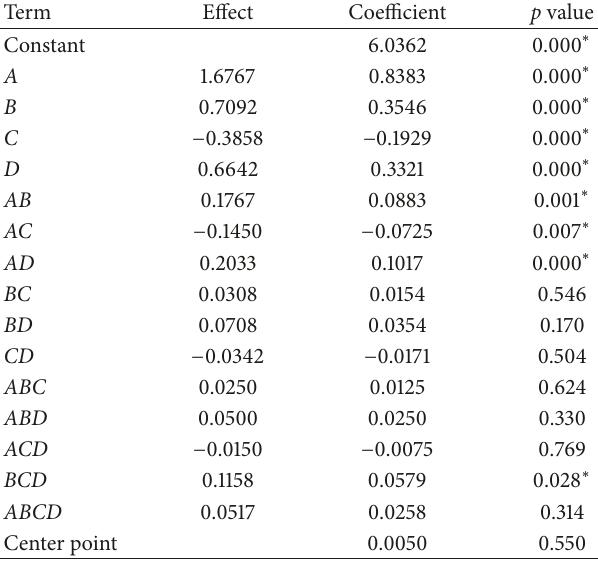
Table 3: Estimated effect and coefficients for coating thickness (coded